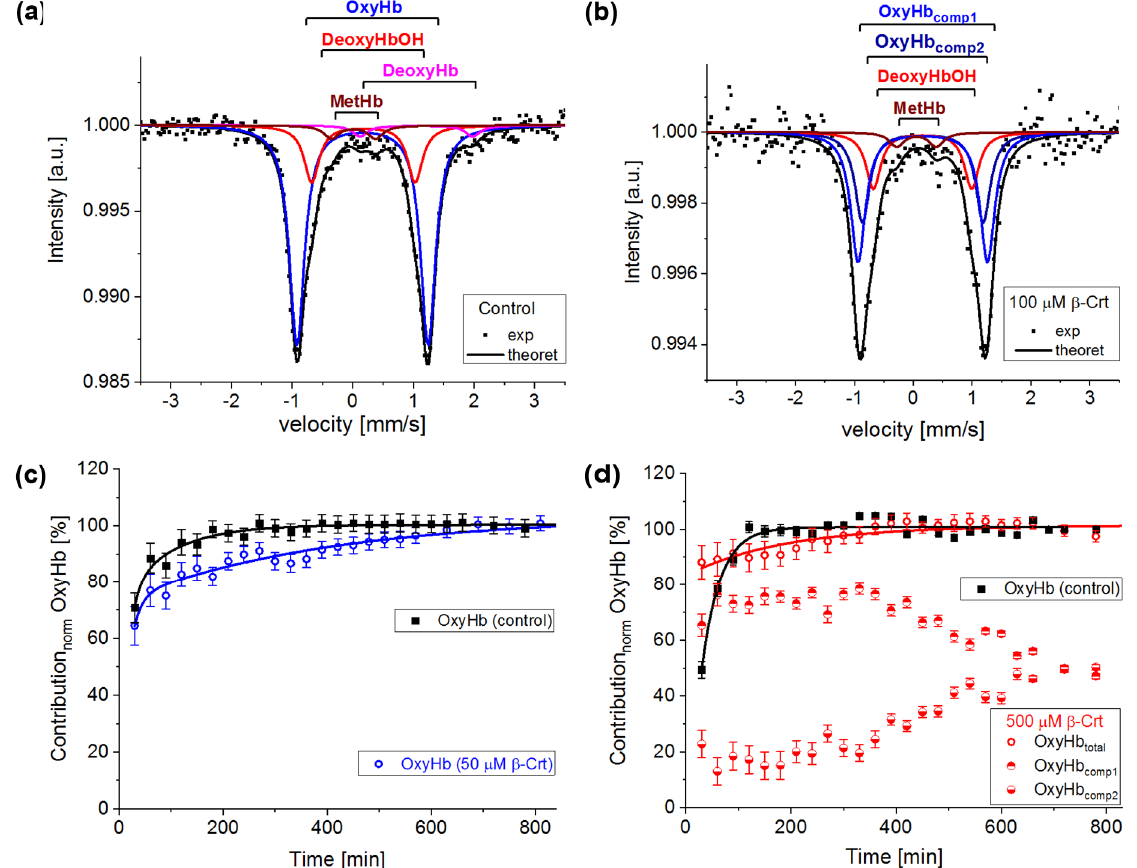
Figure 3. Exemplary steady-state Mössbauer spectra of RBCs: ( a ) untreated (control), and ( b ) incubated with 100 μ mol/L β -Crt (RBCs 100 ) measured at 85 K. The experimental data (exp) is indicated by points and theoretical curves (-theoret) by lines. The characteristic doublets for the different forms of haemoglobin are shown as sub-spectra. Time evolution of the normalised oxyhaemoglobin contribution in RBCs incubated in the presence of 50 μ mol/L β -Crt (blue open circle) ( c ) and 500 µ mol/L β -Crt (red open circle) ( d ), in comparison with respective controls (filled square). Additionally, in ( d ), two resolved subcomponents of oxyhaemoglobin in RBCs 500 are shown (OxyHb comp1 , half-up filled circle; OxyHb comp2 , half-down filled circle). The oxygen saturation level of Hb in the treated and corresponding untreated RBCs was the same within the measurement uncertainty: for RBCs 50 ~73 ± 1% and RBCs 500 72 ± 2%. Error bars shown in Figures ( c , d ) correspond to the accuracy of the theoretical fit of Mössbauer